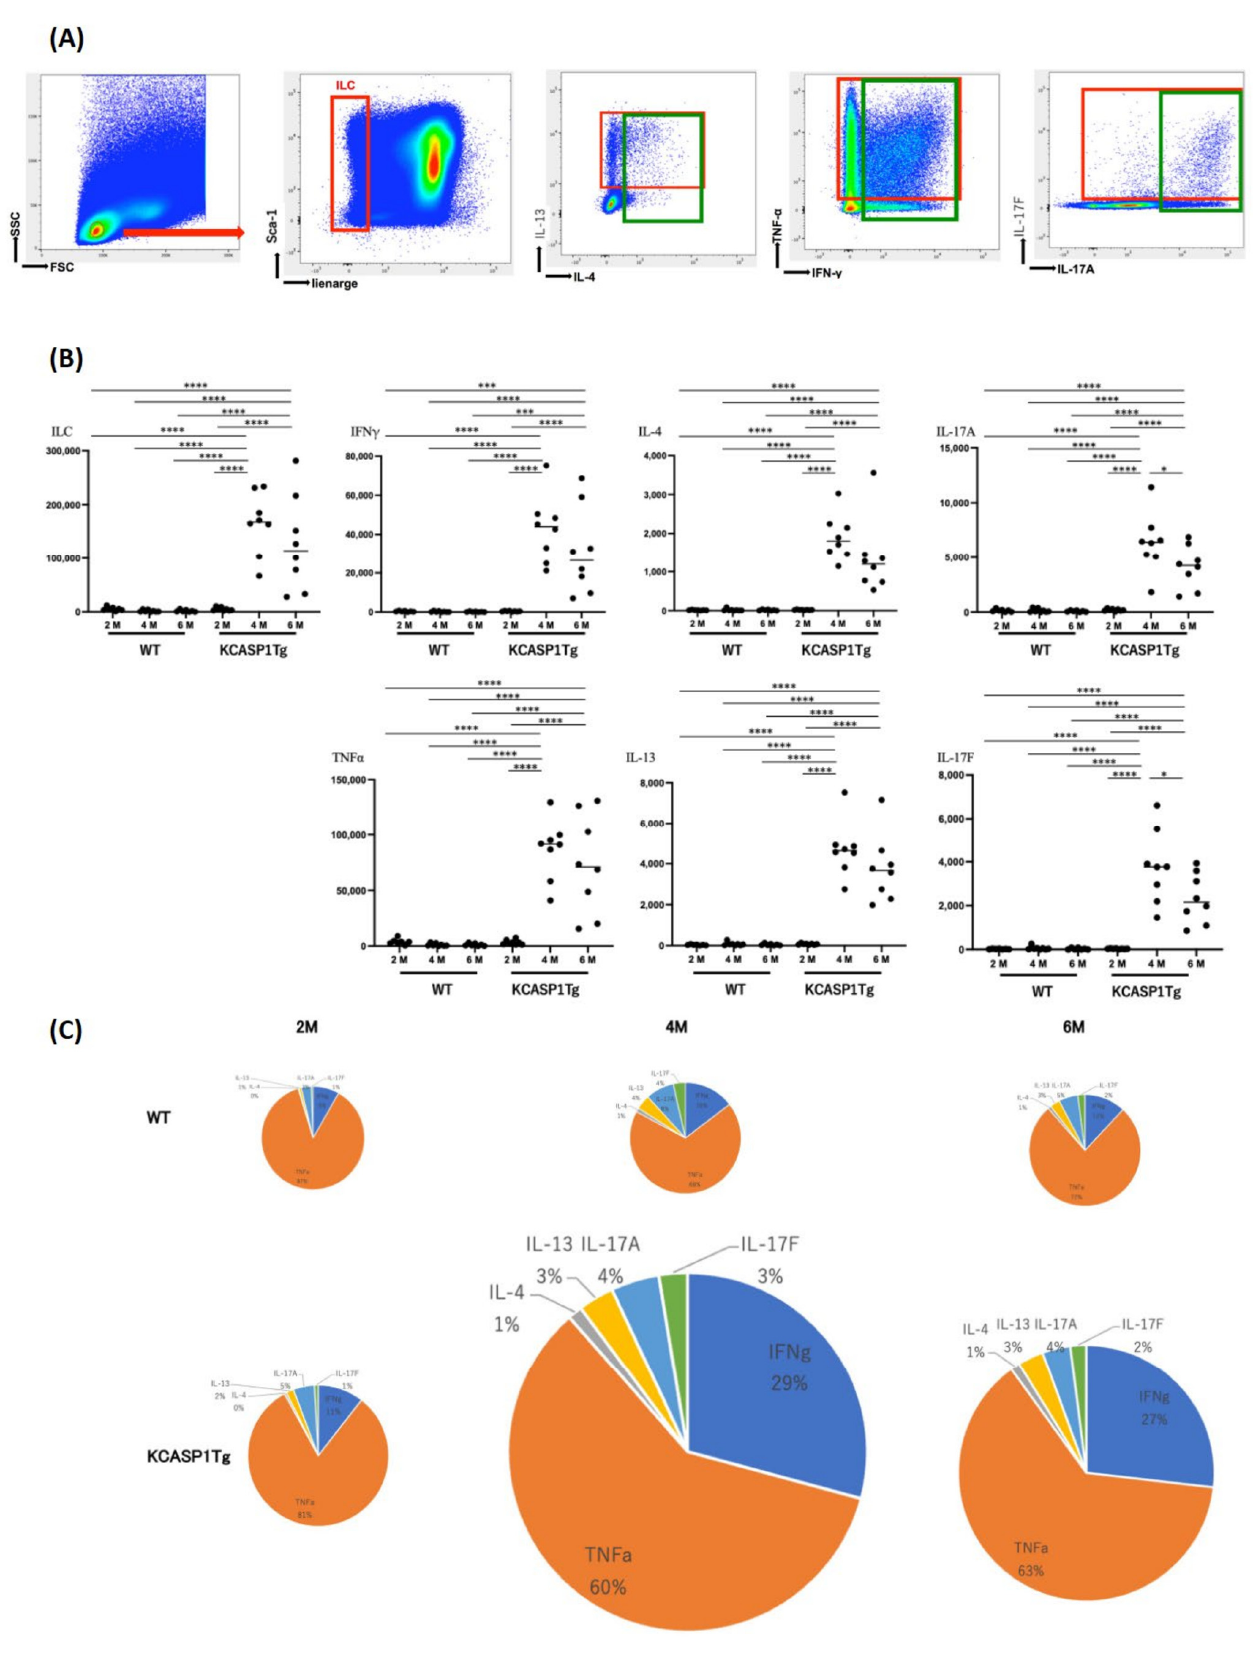
Figure 2. Cytokine production by ILCs. ( A ) The plots represent type 1, 2, and 3 cytokine production by ILCs in 4-month-old KCASP1Tg mice as observed by flow cytometry. ( B , C ) The number of indi- cated cytokine-producing ILCs was measured at 2, 4, and 6 months of age (M). ( C ) Pie chart of the data shown in ( B ). The total number of ILCs peaked at 4 months and decreased at 6 months. The